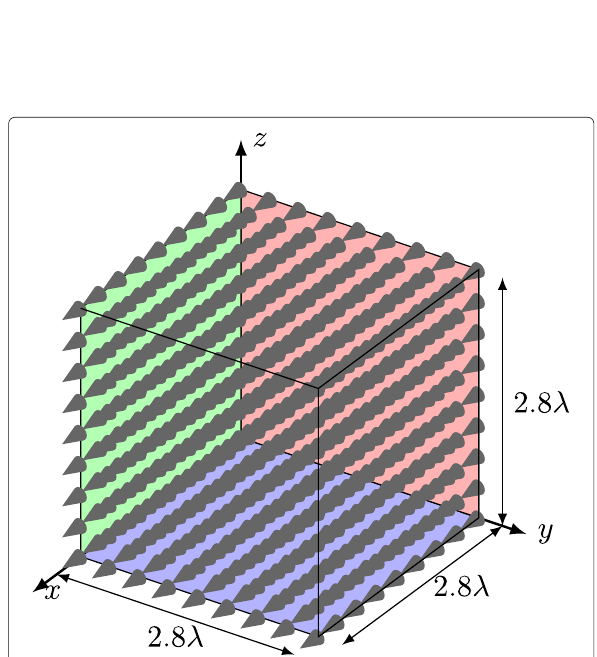
Fig. 11 Spatial sampling grid. For one specific direction, we draw 9 × 9 × 9 = 729 samples uniformly from a cube of side length 2.8 λ . The distance between samples is 0.35 λ with a repeat accuracy of ± 0.004 λ . The orientation of the horn antenna is indicated via the cone shape at the sampling